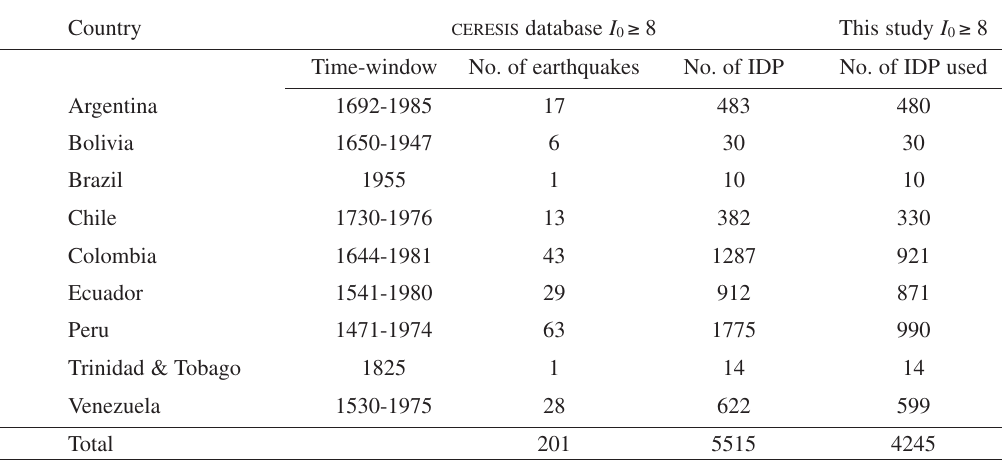
Table III. Number of records in the CERESIS database for earthquakes with I 0 ≥ 8.